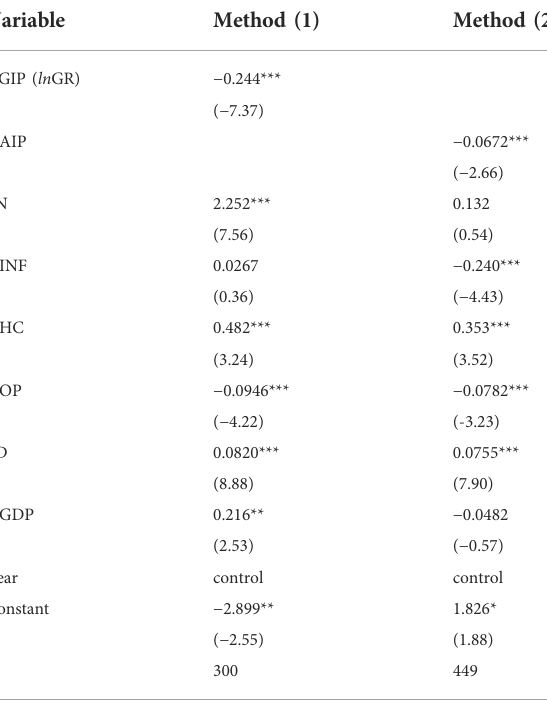
TABLE 6 Robustness test results. TABLE 7 Region-based heterogeneity analysis